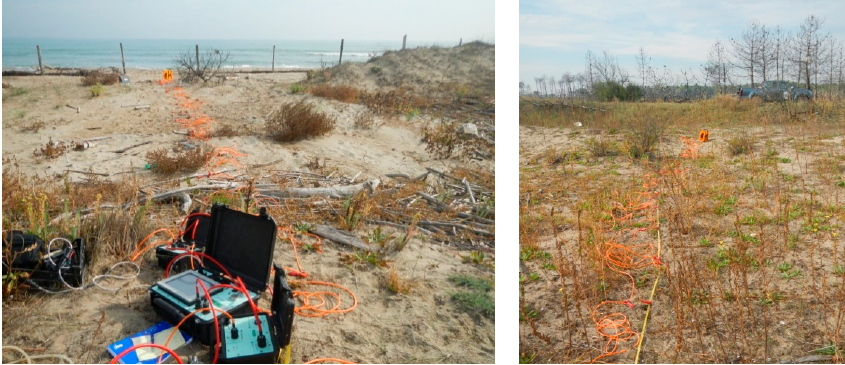
Figure 2. Examples of operating field equipment and study area.